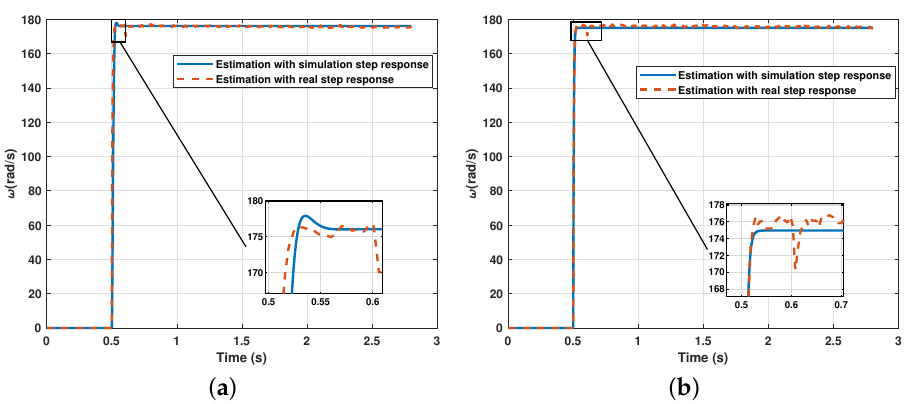
Figure 15. Comparison of the result between the estimation of the transfer function from a real signal and the estimation from a simulated signal: ( a ) Estimation with GWO and FTV; ( b ) Estimation with Jaya and